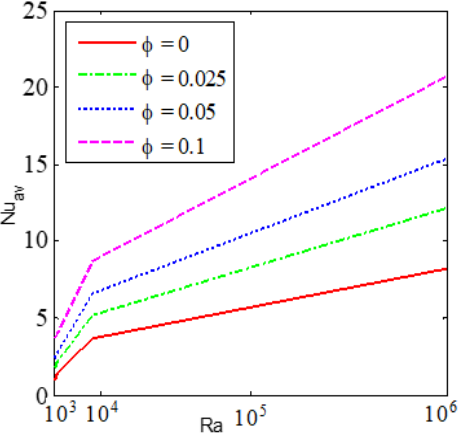
Figure 12. Average Nusselt number ( Nu av ) for different Rayleigh number ( Ra ) and nanoparticles volume fraction ( ϕ ) when λ = 0.5, Ha = 30, d = 10 nm, n = 3, and τ = 1.